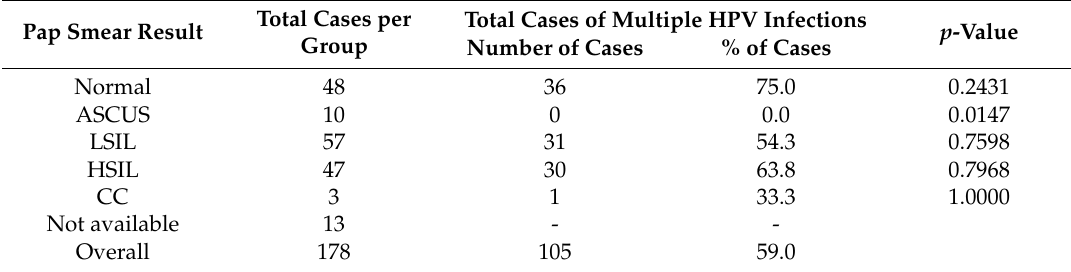
Table 2. Sample Pap smear groups and cases of multiple human papillomavirus (HPV) infections.